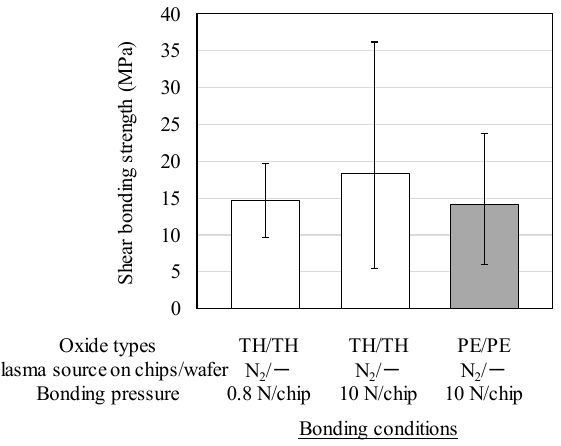
Figure 4. Shear bonding strengths of chips directly bonded to wafers with N 2 plasma activation.